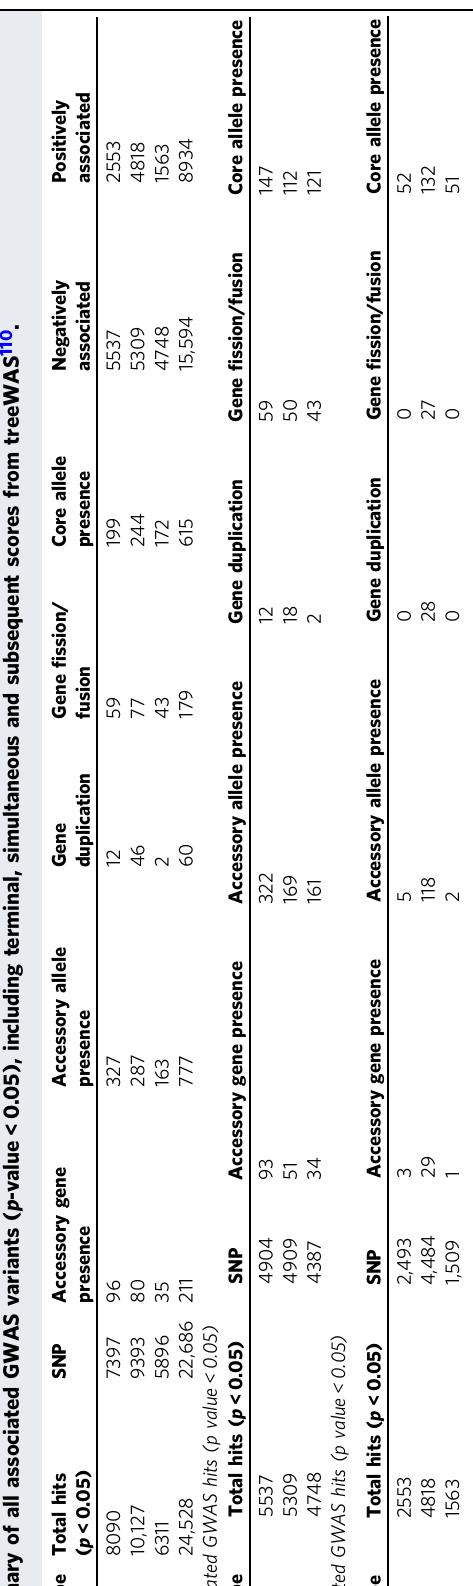
(Fig. 3d, e). Our clinical data suggested that Penner type HS:4- complex was also high-risk (Fig. 1e), but variability in isolate scores for this well-represented group ( n = 18) lowered group ’ s mean risk score and predictive accuracy (1415). PI-IBS isolates are more adhesive and invasive on colonocytes